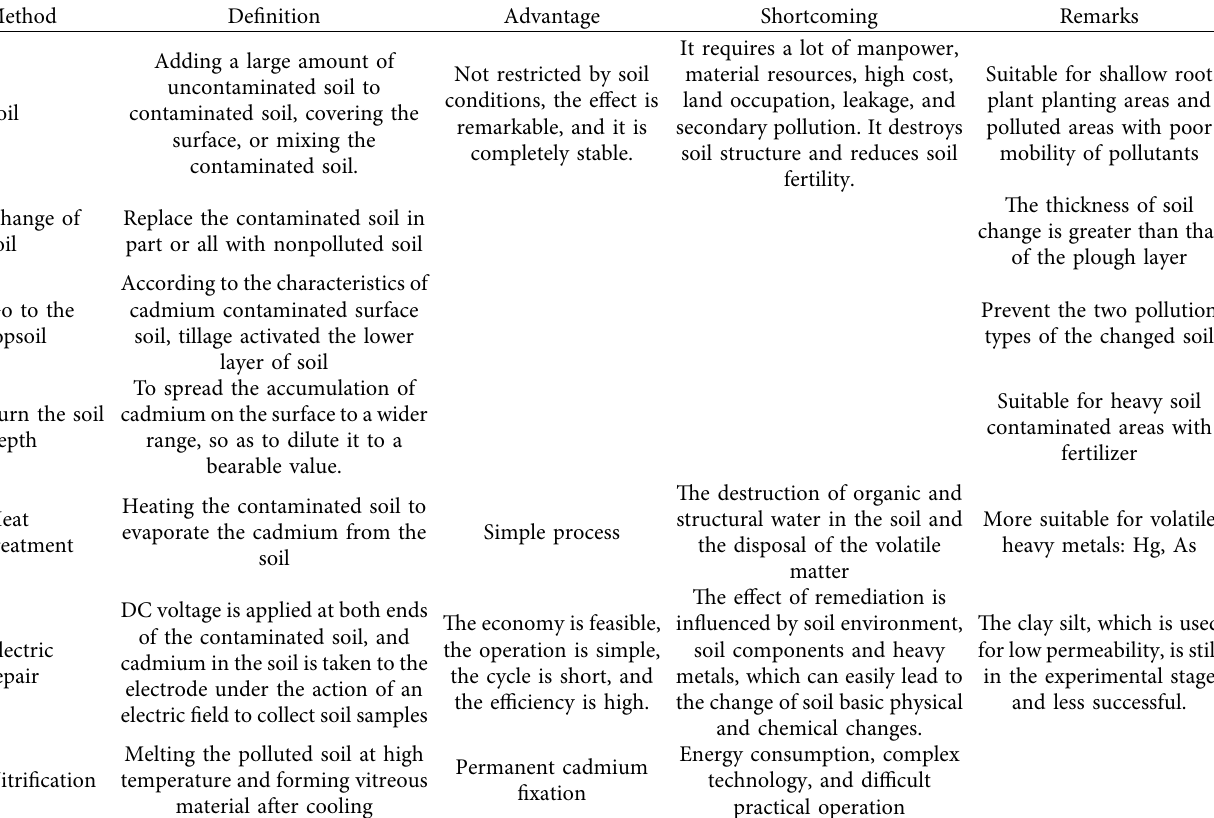
Table 3: Physical remediation of cadmium pollution in soil.